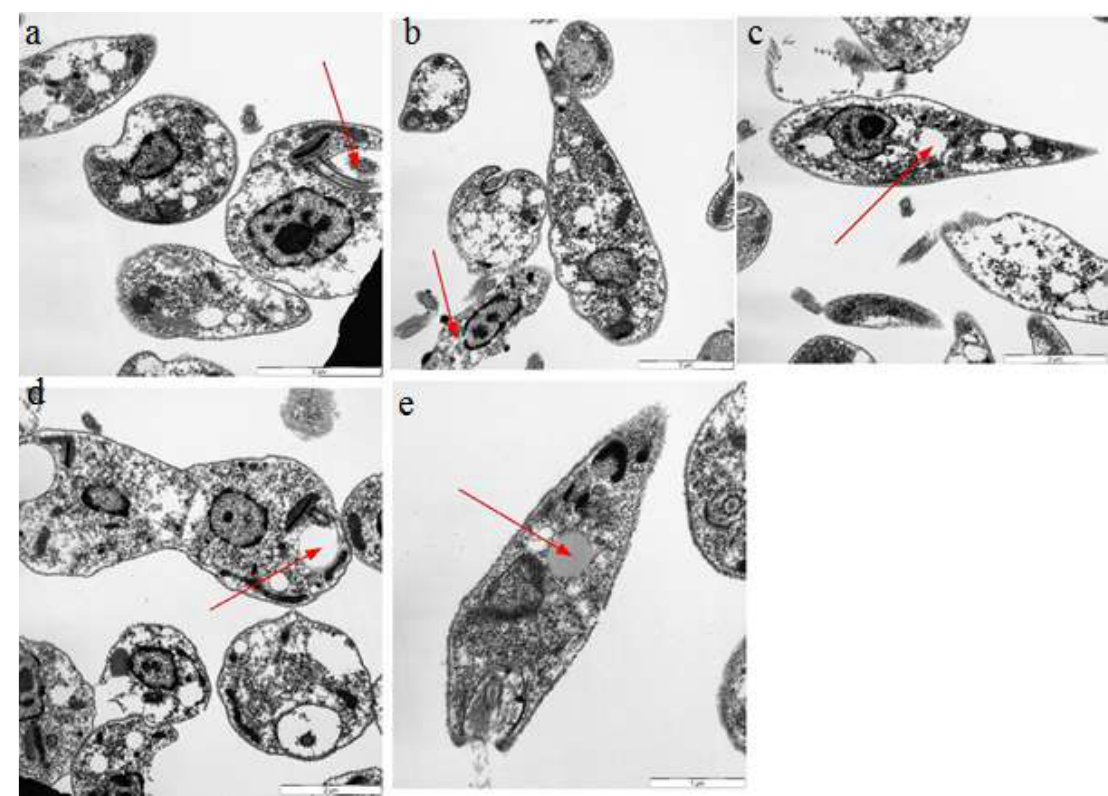
Figure 13. Ultrastructural changes in L. donovani LV82 promastigotes treated with gallic acid at 500 µg/mL for 72 h. ( a ) Distortion of the flagellar pocket, ( b ) acidocalcisomes, ( c , d ) large number of vacuoles, and ( e ) lipid reservoirs.